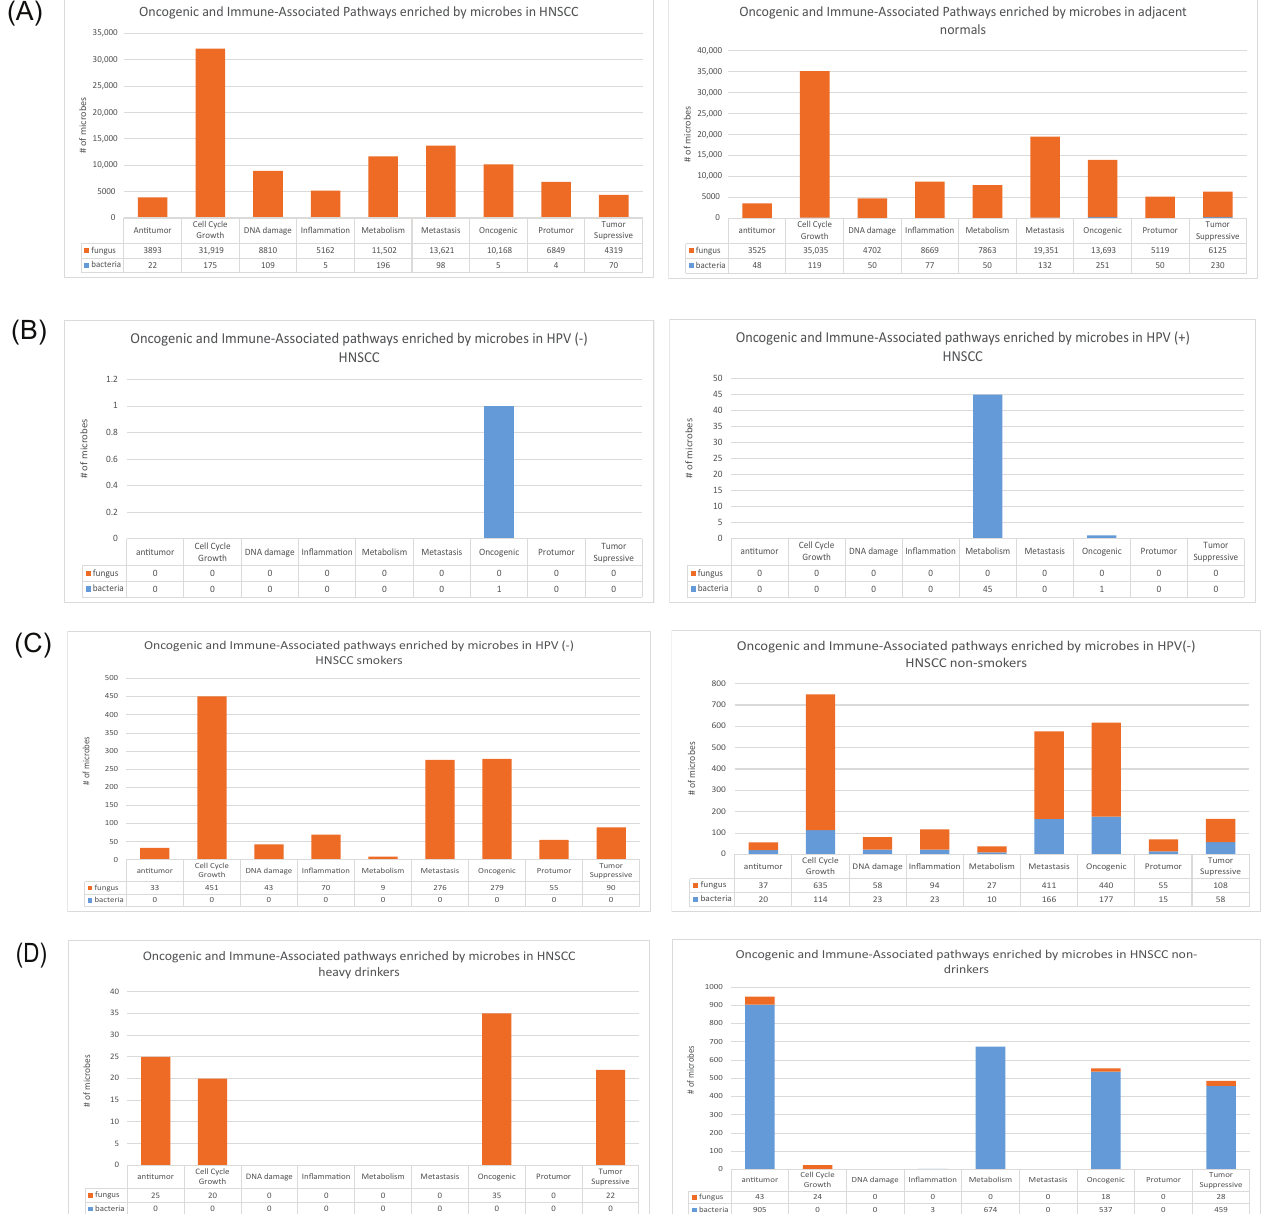
Figure 8. Enriched oncogenic and immune-associated signatures associated with dysregulated microbes. Gene set enrichment analysis (GSEA) was conducted to identify unique oncogenic and immune-associated pathways associated with dysregulated microbes ( p < 0.05 and false discovery rates (FDRs) < 0.25). GSEA signatures were classified into the following categories for analysis purposes: antitumor, Cell Cycle/Growth, DNA damage, Inflammation, Metabolism, Metastasis, Oncogenic, Protumor, and Tumor-Suppressive. Orange corresponds to fungal microbes, while blue corresponds to bacterial microbes. ( A ) Bar plots visualizing pathway enrichment for dysregulated microbes in HNSCC tumor samples and adjacent normal samples. Dysregulated fungi were found to disproportionately account for enriched pathways when compared to bacteria across both tumor and normal samples. ( B ) Bar plots visualizing pathway enrichment for dysregulated microbes in the HPV- and HPV+ HNSCC samples. Only one bacterial microbe was significantly correlated with pathways for the HPV- HNSCC cohort, while 45 bacteria were correlated with enriched signatures pertaining to metabolism and carcinogenesis in the HPV+ HNSCC cohort. ( C ) Bar plots visualizing